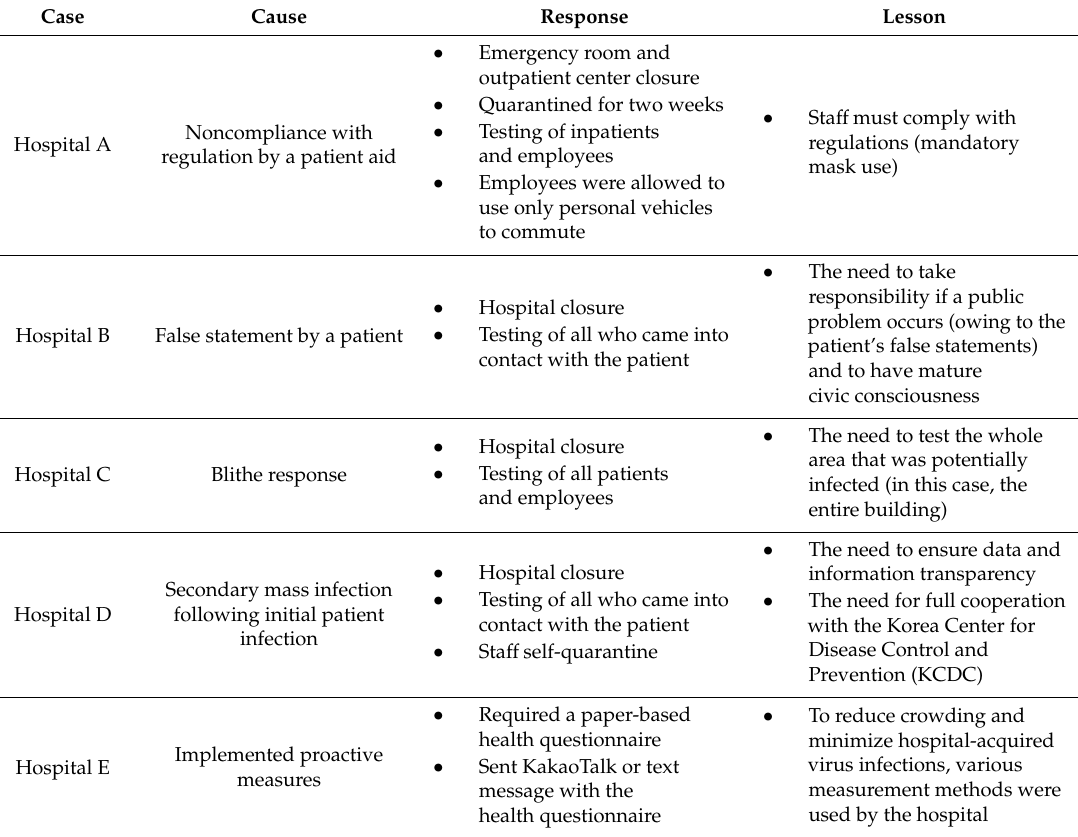
Table 3. Example hospitals with confirmed COVID-19